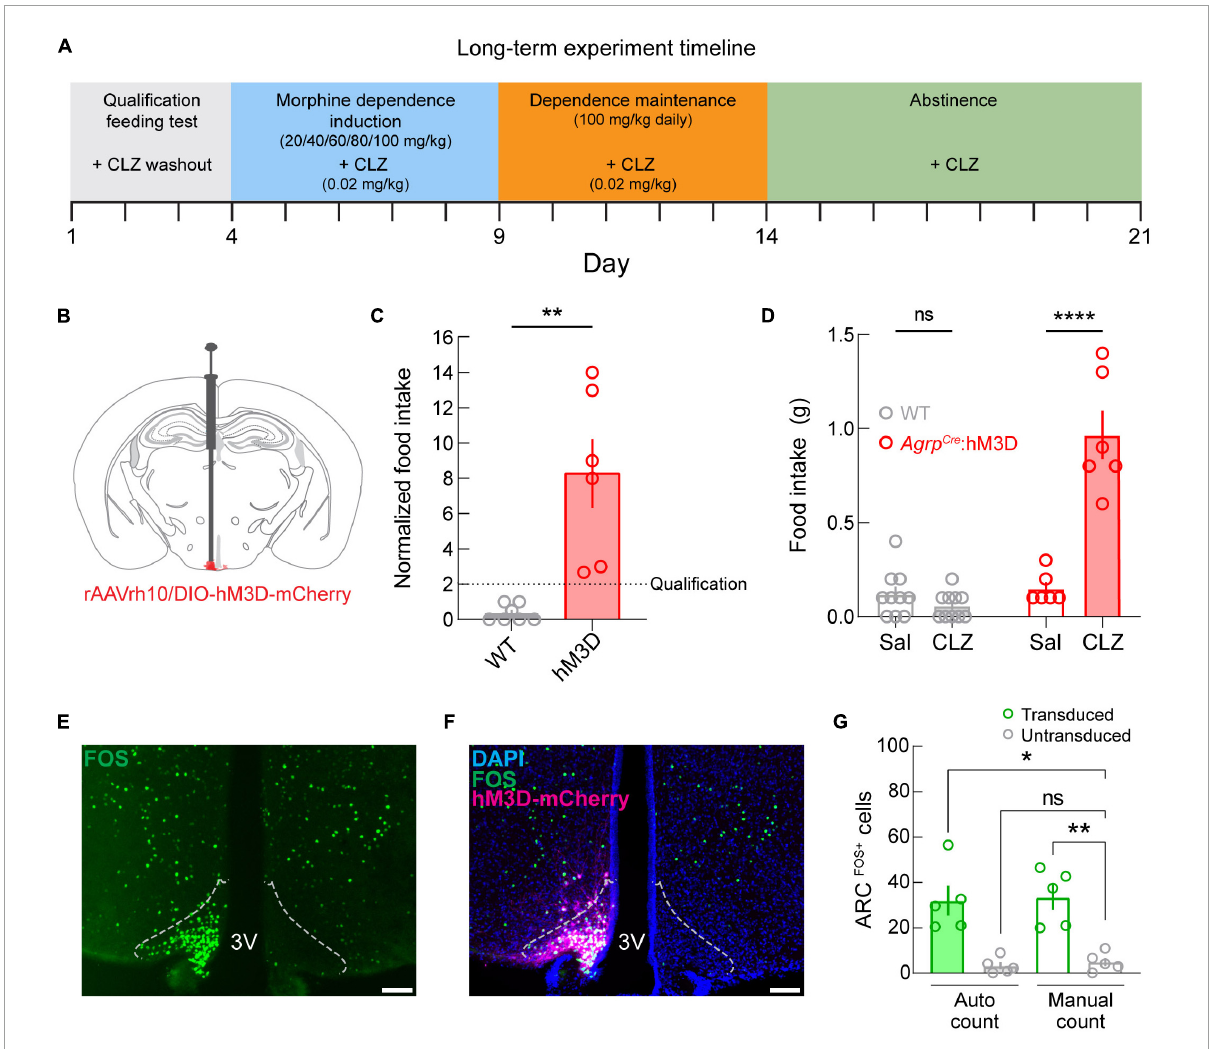
FIGURE4 Long-term manipulation experimental design, qualification, and validation. (A) Diagram depicting the experimental timeline. (B) Diagram depicting viral microinjection into the ARC in Agrp Cre ( Agrp Cre :hM3D; experimental) and Agrp WT (WT; control) mice. (C) Qualification of mice by normalized food intake. The dotted line denotes the qualification threshold. Experimental mice were included ( n = 6 of 9 Agrp Cre :hM3D mice) if they consumed twice the food during the clozapine (CLZ) test compared to the saline (Sal) test. As expected, WT mice failed to meet the criterion ( n = 0 of 10 mice) but were not excluded from further testing. (D) Raw food intake values for the qualification test show that food intake is increased under the clozapine condition specifically in the Agrp Cre :hM3D group. (E) Image of FOS immunostaining (green) showing dense fluorescently labeled cells in a single hemisphere of the ARC. Dotted outlines represent approximate ARC boundaries. Scale bar = 200 µ m. (F) Merged image showing DAPI (blue), FOS (green), and hM3D-mCherry (magenta) expression. Dotted outlines represent approximate